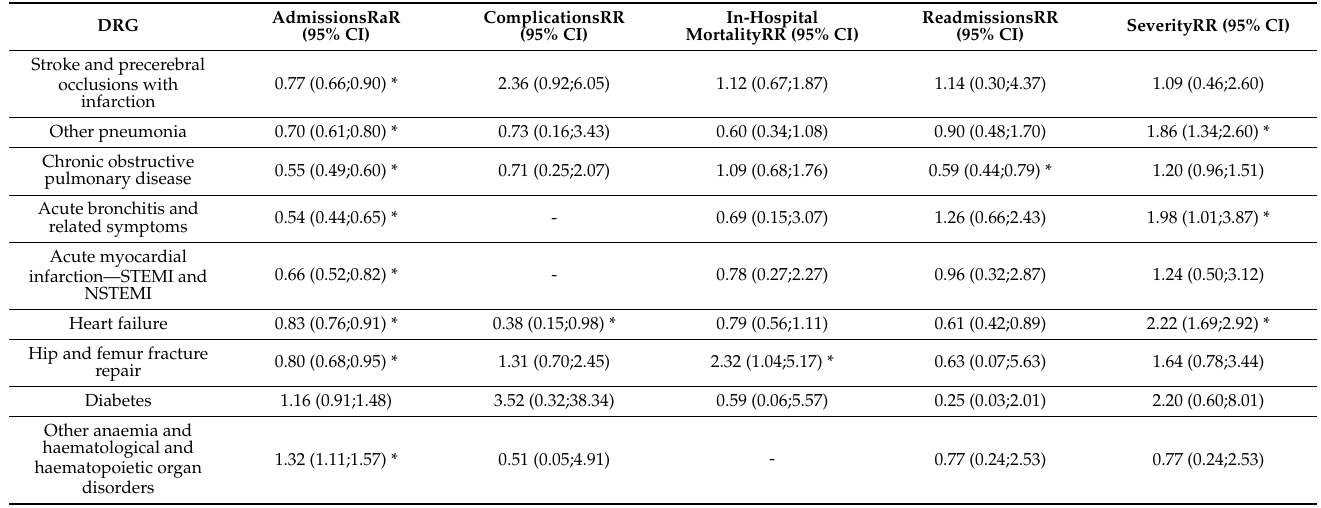
Table 4. Comparison of admissions, complications, mortality, readmissions, and severity between pre-COVID and COVID periods by a selection of DRG for chronic and acute conditions. DRG: Diagnosis Related Group. RaR: rate ratio. RR: risk ratio. STEMI (ST elevation myocardial infarction) and NSTEMI (non-ST elevation myocardial infarction). * p value <